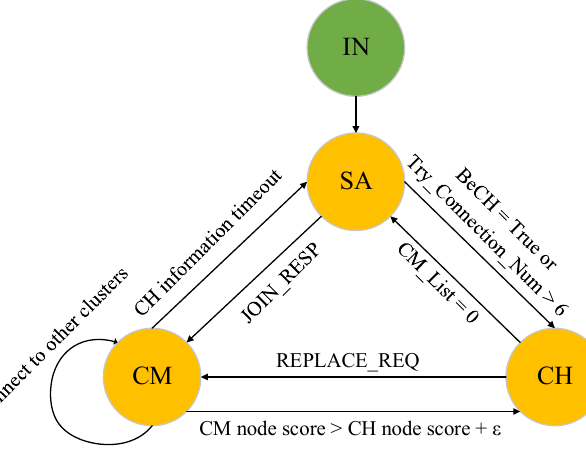
Figure 3. Node state transition diagram.